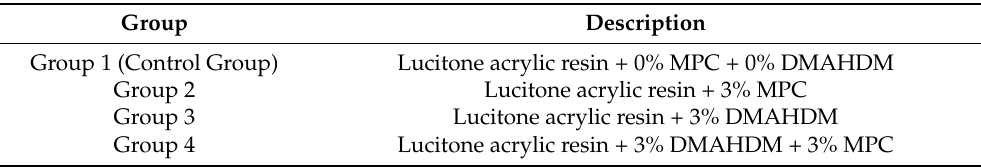
Table 1. Description of different groups investigated.